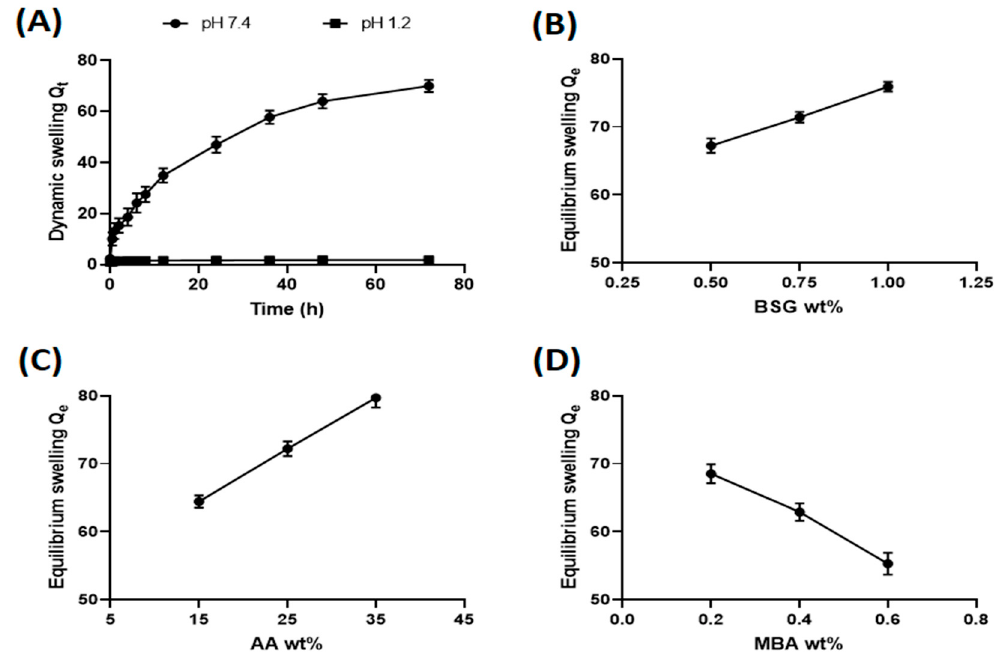
Figure 9. ( A ) Effect of different pH mediums on dynamic swelling; ( B ) effect of BSG, ( C ) effect of AA, ( D ) MBA wt.% on swelling.